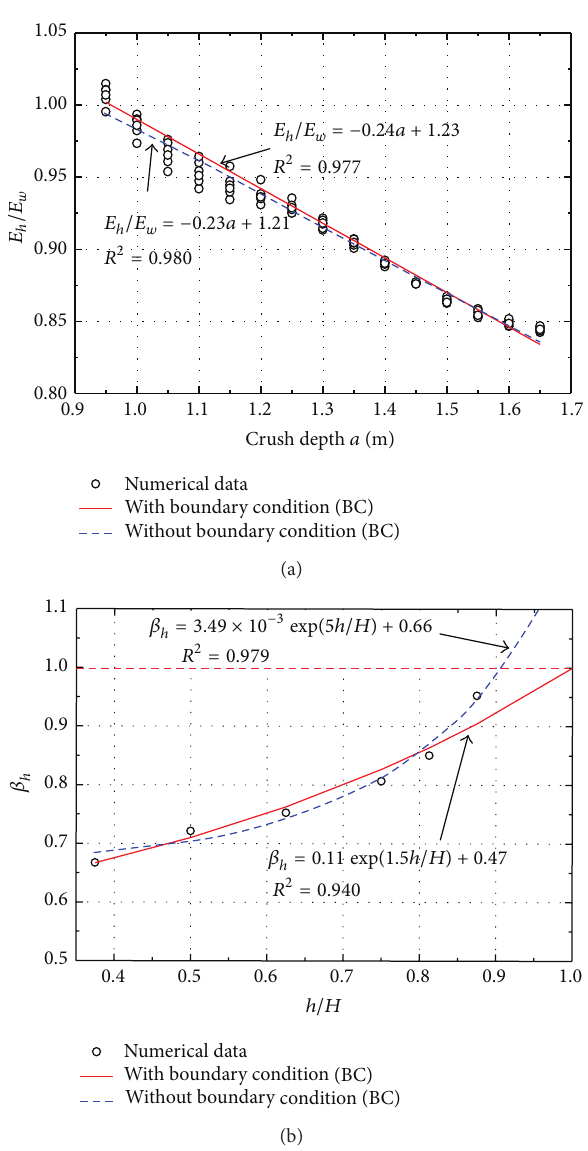
Figure 13: Phase analysis of 5,000 DWT ship bow: (a) Phase II; (b) Phase